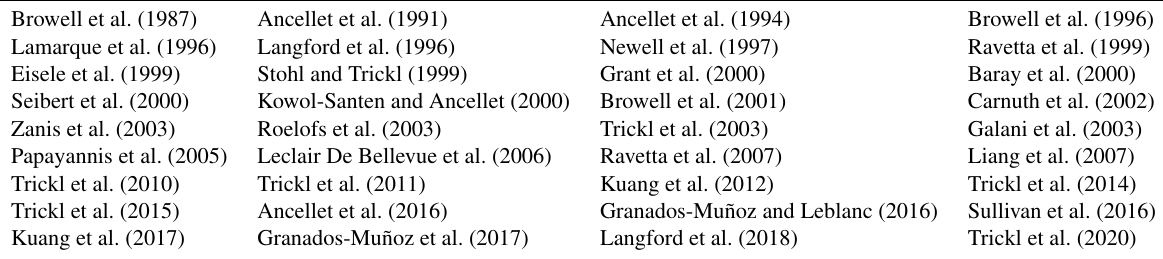
Table A1. List of citations for atmospheric transport studies including ozone lidar systems.